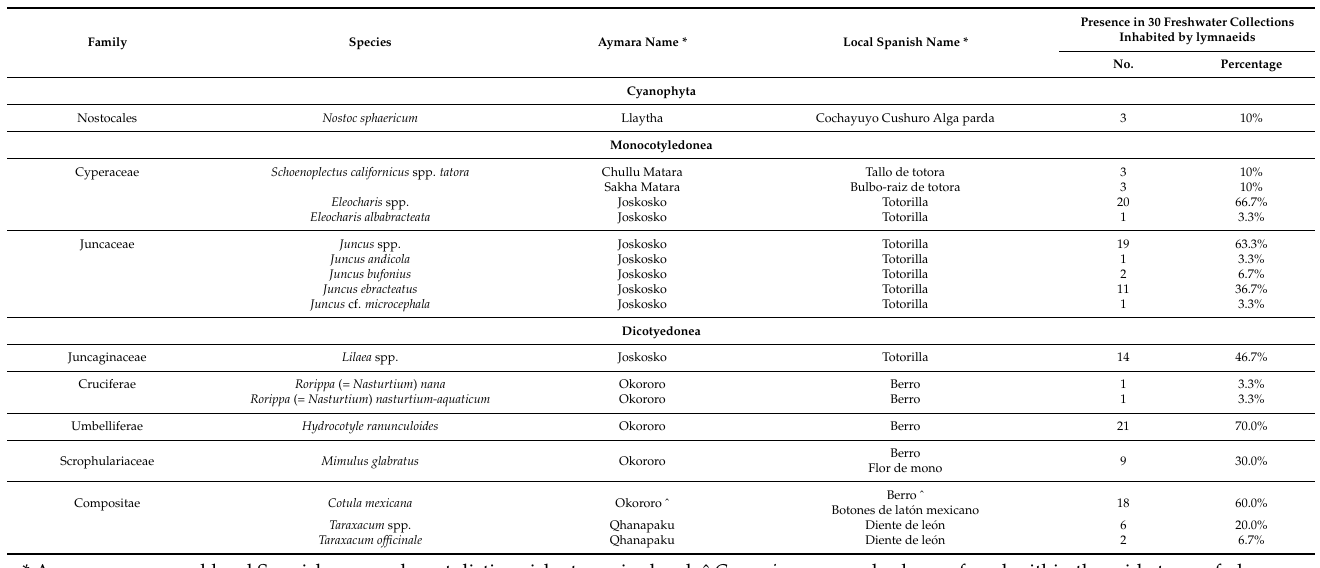
Table 1. Edible aquatic and semi-aquatic plants most frequently present in fascioliasis freshwater foci in the Northern Bolivian Altiplano and consumed by Aymara